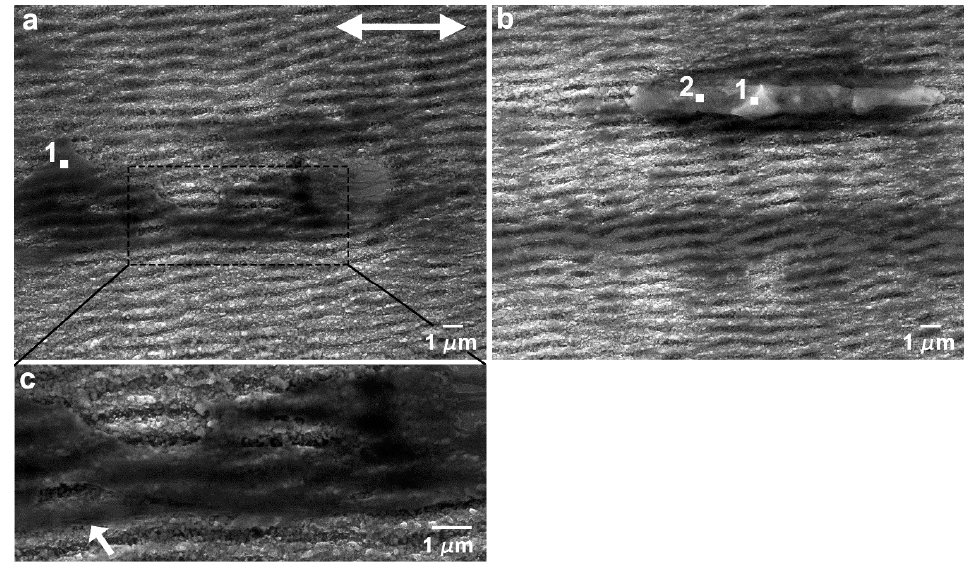
Figure 9. Wear tracks at 5 mN after ( a ) 50 cycles and ( b ) 1000 cycles; at 10 mN after ( c ) 50 cycles and ( d ) 1000 cycles; and at 25 mN after ( e ) 50 cycles and ( f ) 1000 cycles. The double arrow indicates the sliding direction, parallel to the LIPSS orientation.